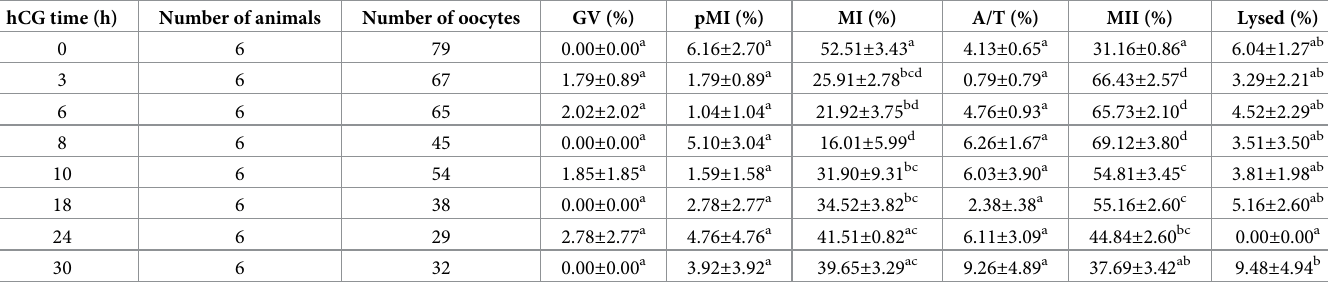
* Different superscript letters (a, b or ab) in the same column indicate statistical significance between different variables (P < 0.05). hCG time refers to the first time of subcutaneous injection of hCG to removal of ovaries; hCG, human chorionic gonadotropin; GV: germinal vesicle; pMI: pro-metaphase I; MI: metaphase I; AI: anaphase I; TI: telophase I; MII: metaphase